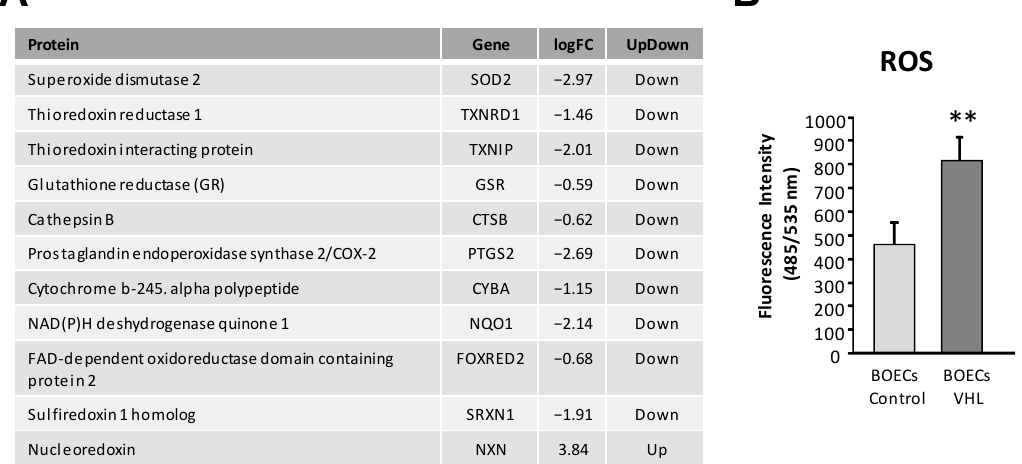
Figure 7. ( A ) ROS metabolism modulation in RNAseq analysis in VHL ECs. ( B ) ROS levels in control and VHL cells, showing a significant increase in VHL samples. Error bars denote ±SEM. Student’s t -test: ** p < 0.01.